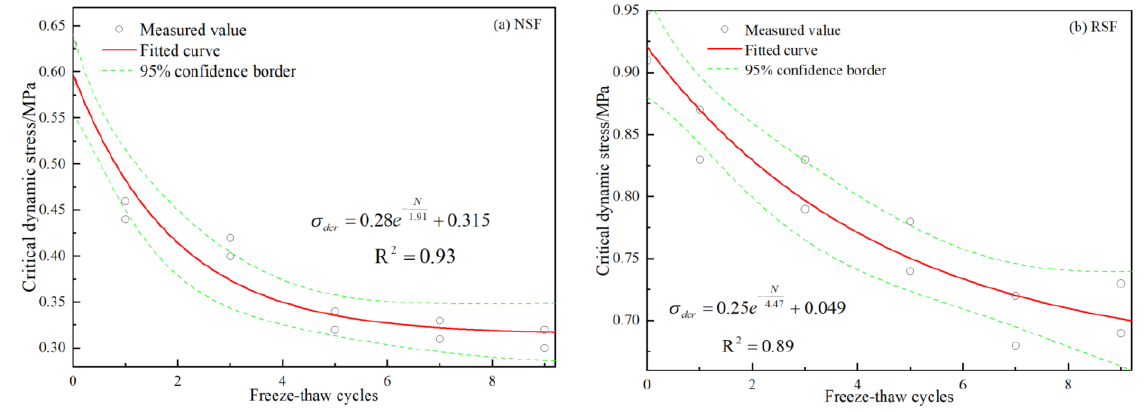
Figure 10. Variation in critical dynamic stress with FT cycles ( a ) for NSF, ( b ) for RSF.